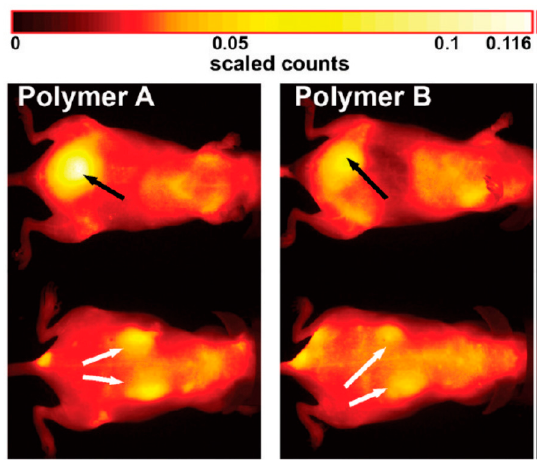
Figure 4. Distribution of HPMA-based copolymers in healthy SKH-1 mice 6 h after i.v. administration of 1 mg linear HPMA (30 kDa, polymer A) or star-like HPMA (200 kDa, polymer B) in dorsal and abdominal images. Arrows mark bladder (black) and kidneys (white). Reprinted with permission from [31]. Copyright [2012] American Chemical Society.